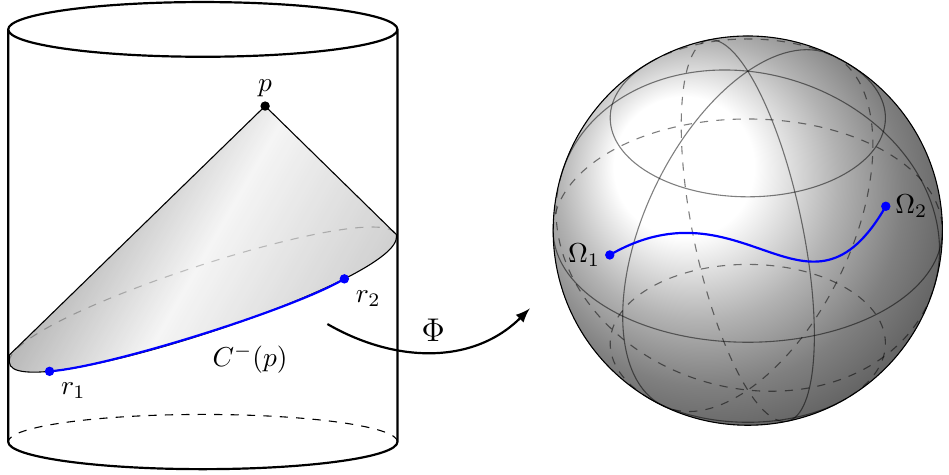
Figure 4 . The map (cid:8) de(cid:12)ned in (3.11) takes (regular) points in the cut C ( p ) of a point p and maps them to S k . For instance, the blue segment between points r 1 ; r 2 blue segment between points (cid:10) 1 ; (cid:10) 2